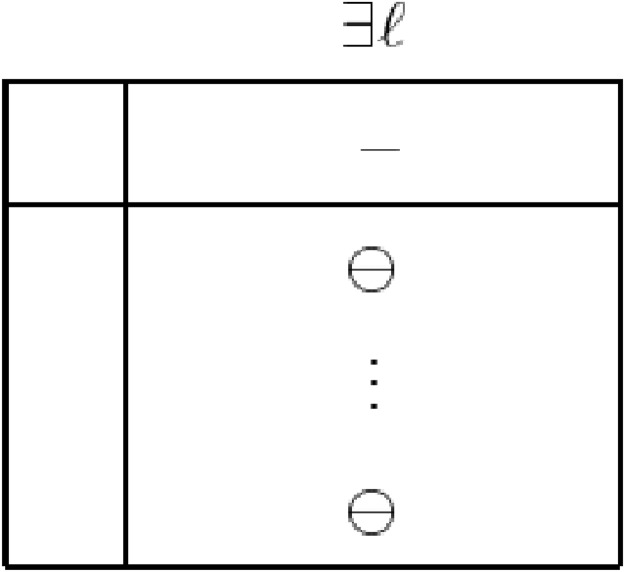
A short simplex table structure showing inconsistency of dual problem.